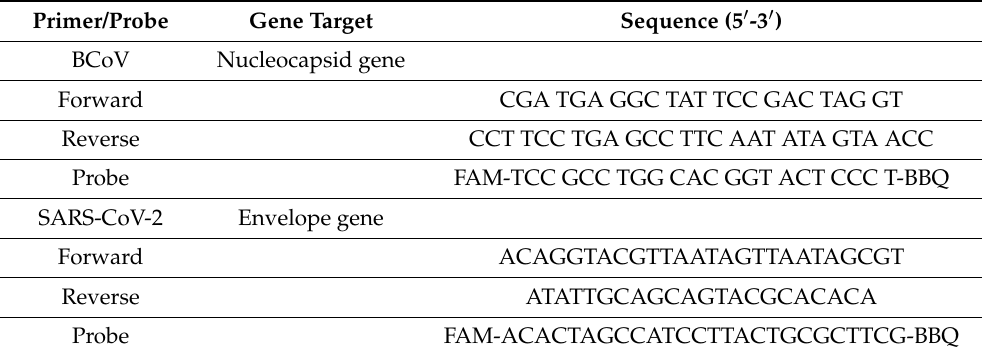
Table 1. Primer and probe sequences used in real-time RT